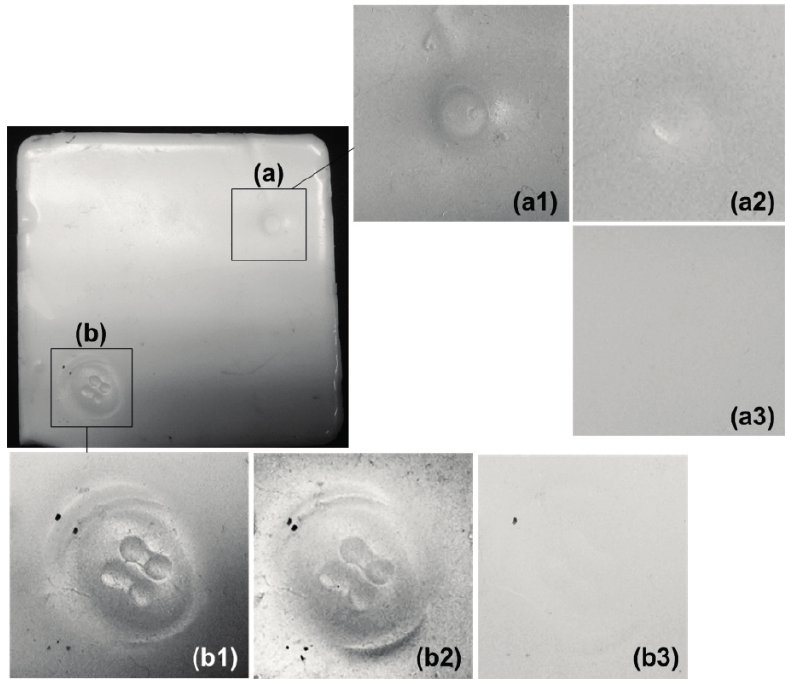
Figure 9. Multiple-SME in silicone-melting glue hybrid. ( a , b ) are two indents. Upon gradual heating (1–3), ( a ) almost disappears in step 2, while ( b ) only disappears in step